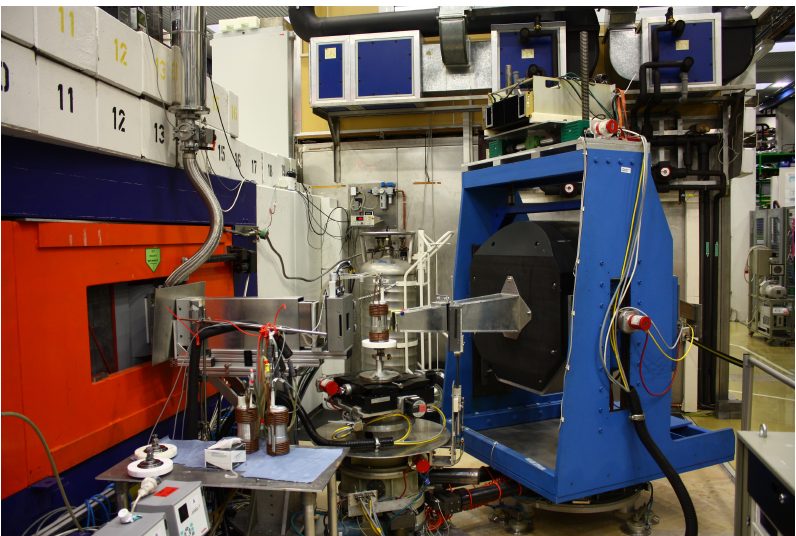
Figure 1: View of the Membrane Diffractometer V1; left: monochromator shielding; middle: sample position on omega-table; right: 2-dimensional detector with lift.